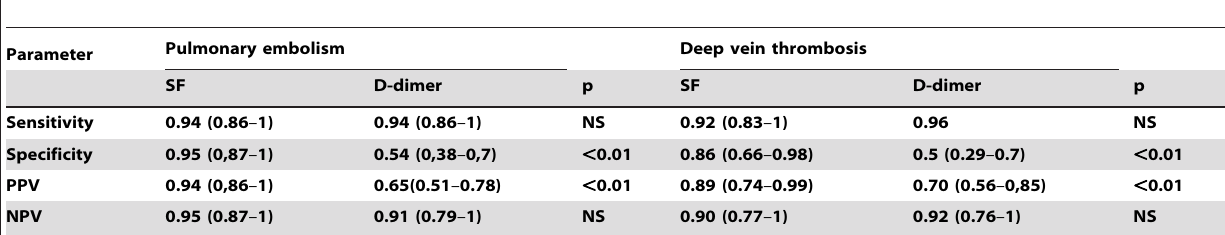
Table 5. Sensitivity, Specificity, Positive- (PPV) and Negative-Predictive Values (NPV) (95% Confidence Intervals) for Soluble Fibrin (SF) and D-dimer concentrations in Pulmonary Embolism and Deep Vein